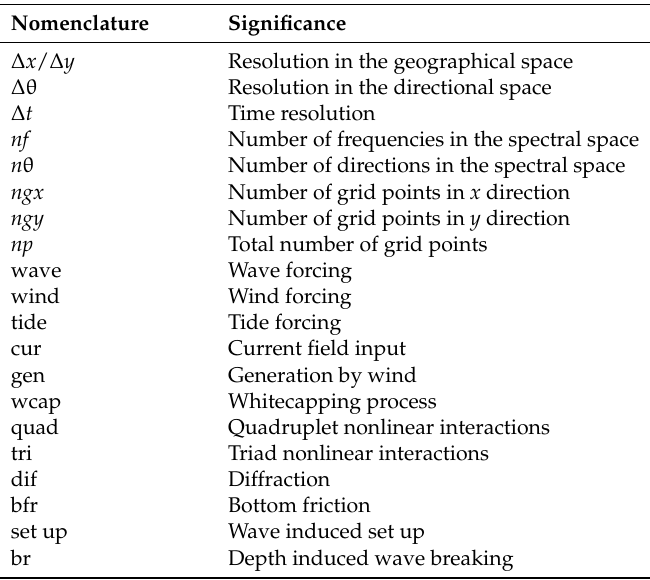
Table 1. SWAN parameters significance.